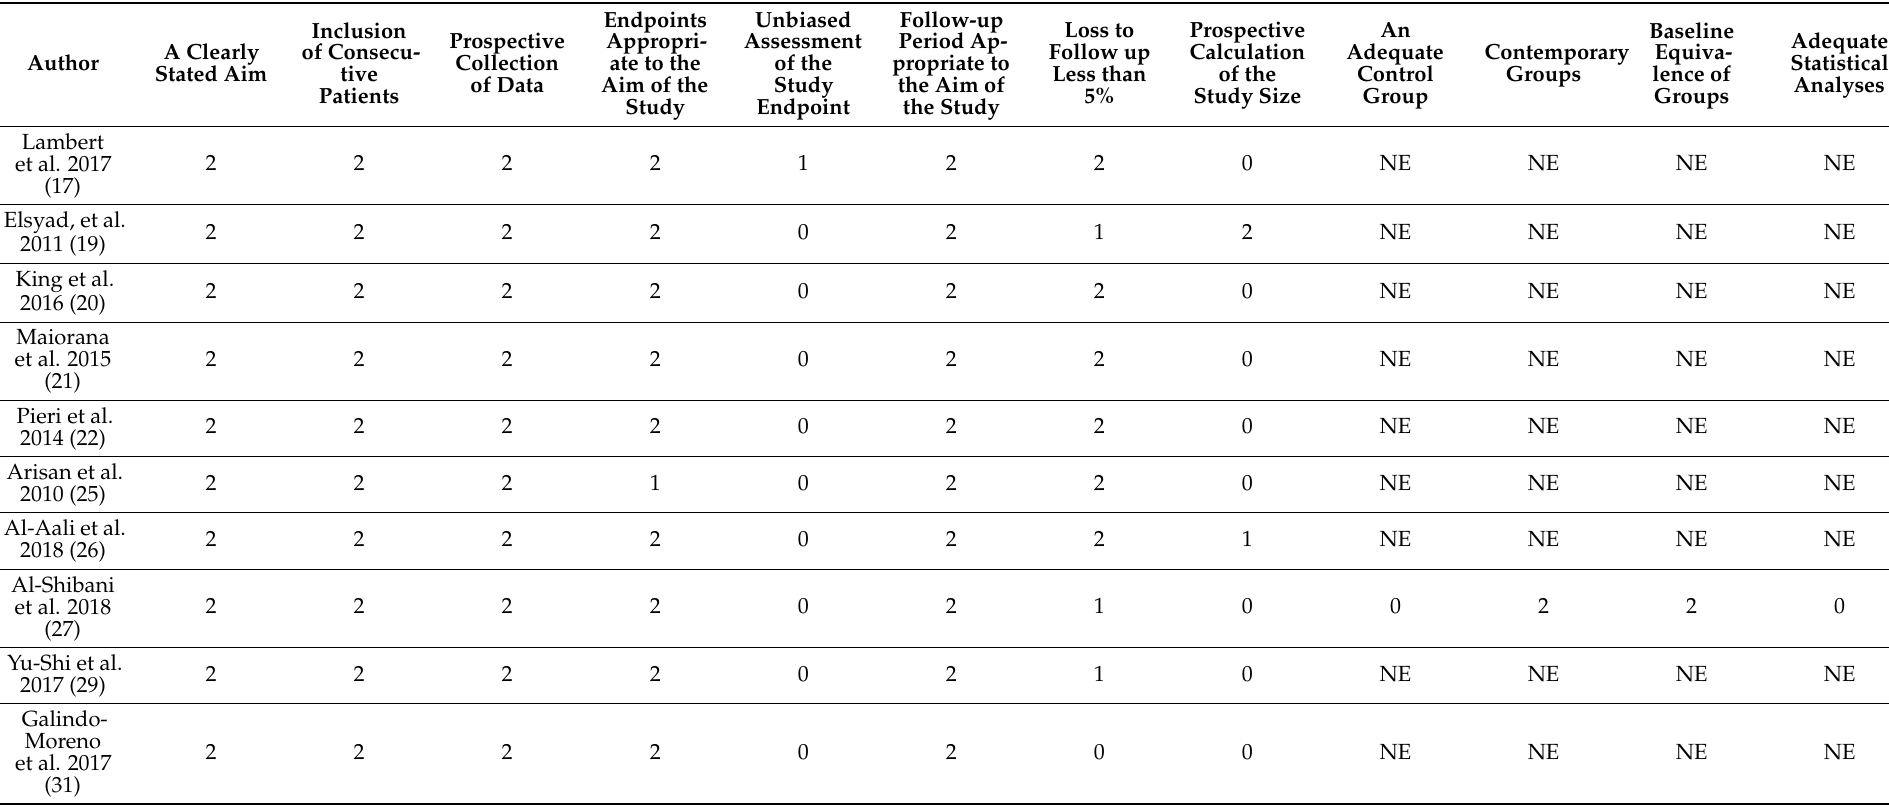
Table 3. Risk of bias of included non-randomized clinical trials. 0 (not reported), 1 (reported but inadequate) or 2 (reported and adequate), NE (not evaluable, no group